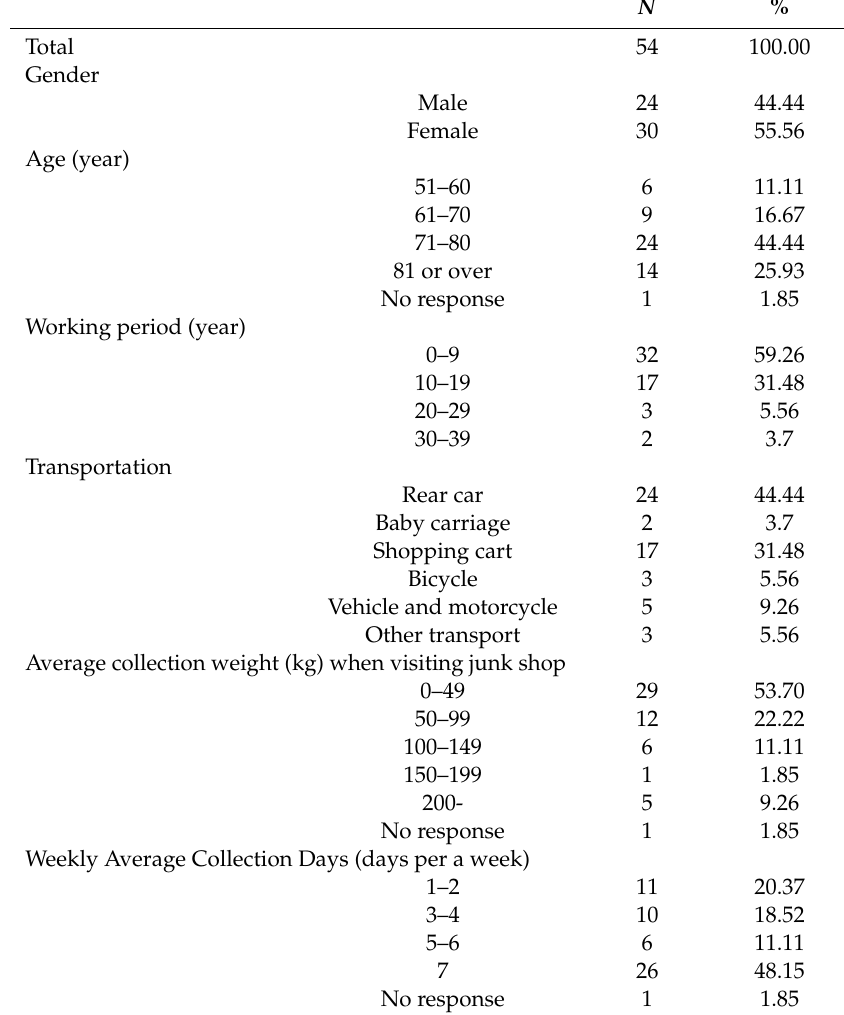
Table 2. Basic characteristics of study